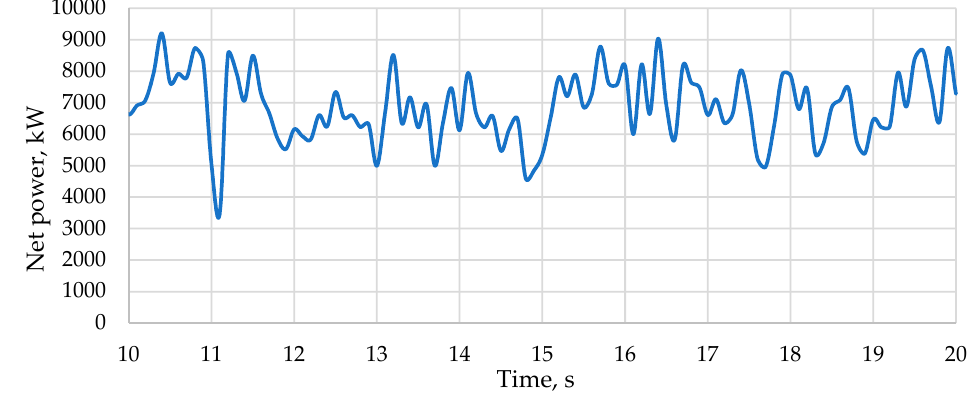
Figure 12. Net drive power obtained from simulation.